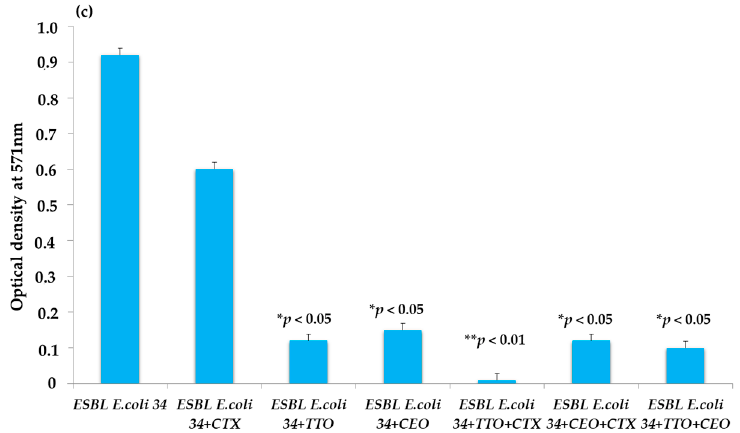
Figure 3. Effect of selected EOs, alone and in combination with reference antibiotic, on mature biofilm formed by VRE B5 ( a ), MRSA O ( b ), and ESBL E. coli 34 ( c ) strains. p -values of <0.05 (*), <0.01 (**), <0.001 (***) were considered significant by t -test and ANOVA.